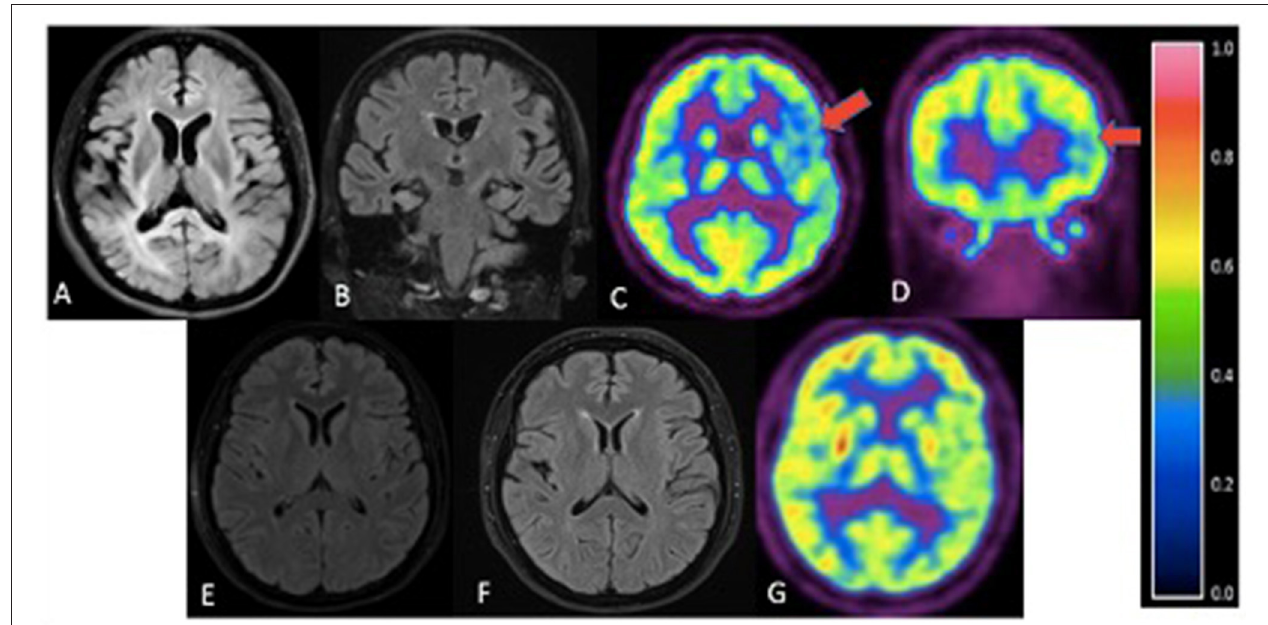
FIGURE 3 | Cranial imaging of family members. (A) - III-10. Axial FLAIR. Mild atrophy of both temporal lobes. (B) - III-8. Coronal FLAIR MRI. Mild atrophy of bilateral parietotemporal areas. (C,D) III-8. Axial (C) and coronal (D) FDG-PET. Mild diffuse FDG hypometabolism in the left parietotemporal cortex (red arrows) with reference color scale to signify FDG uptake. (E) - III-6. Axial FLAIR. Unremarkable MRI. (F) - III-7. Axial FLAIR. No significant atrophy or hyperintensities. (G) - III-7. FDG-PET scan revealed no definite focus of abnormally increased or decreased FDG